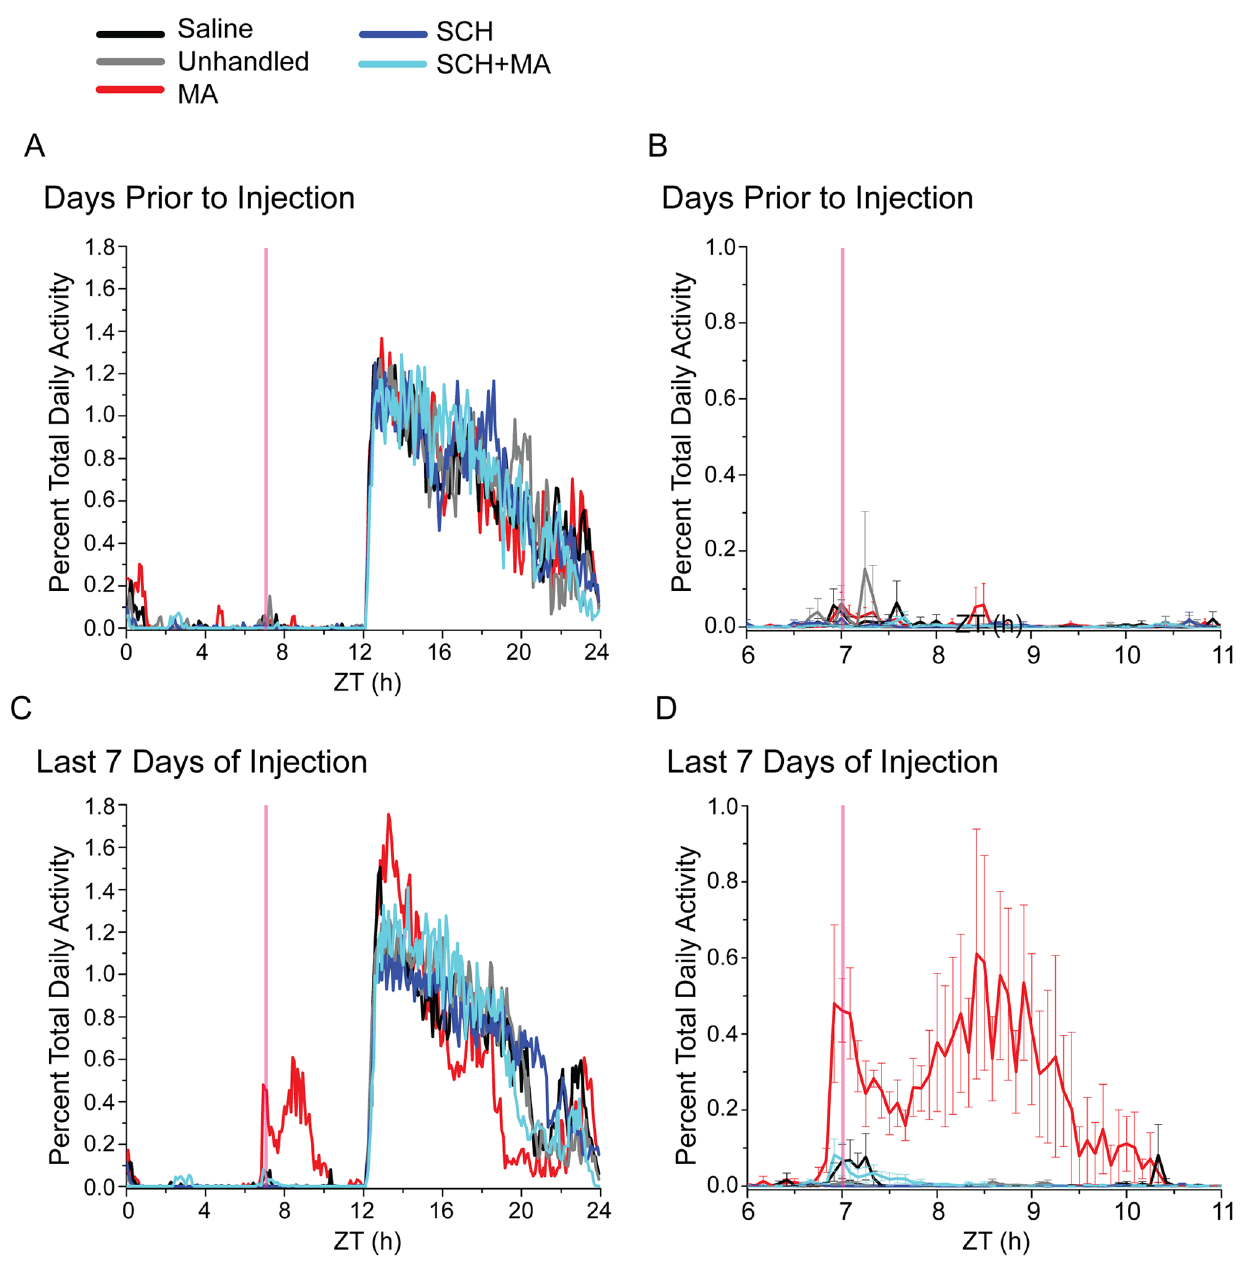
Figure 2. Average activity profiles from mice receiving scheduled daily saline (black), left unhandled (gray), receiving scheduled daily MA (2 mg/kg) injections (MA, red), receiving daily D1 receptor antagonist injections (SCH, blue), and receiving pretreatment with a D1 receptor antagonist followed by MA (SCH + MA, aqua). Activity data are averaged from 5 min bins across days 4 days prior to the start of injections (day 2 5 to 2 2, where day 0 is the first day of injections; Fig. 2A and 2B) or the last 7 days of injections (day 3 to 9; Fig. 2C and 2D). Data are expressed as percent of total daily activity, and zeitgeber time (ZT) is along the x-axis. The time of MA injection (ZT7) is indicated by the pink vertical line. A) and B) illustrate the full 24h activity profiles, plotted as the mean percent of total daily activity. C) and D) are enlarged data from ZT6- 11, plotted as the mean 6 SEM percent of total daily activity. Note the robust increase in activity level beginning immediately prior to and extending for 3–4h hours following injection in the MA group